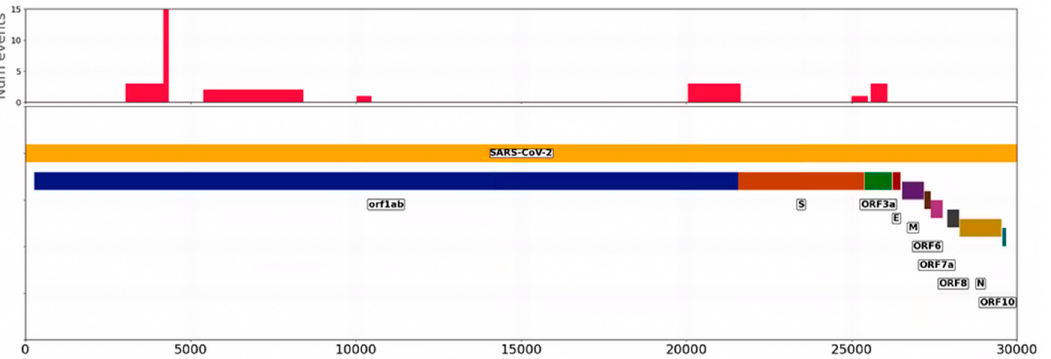
Figure 7. Histogram of the occurrence of breakpoints along the SARS-CoV-2 genome. The Y axis represents the number of samples in which the breakpoint was observed. The lower part represents the different SARS-CoV-2 proteins.